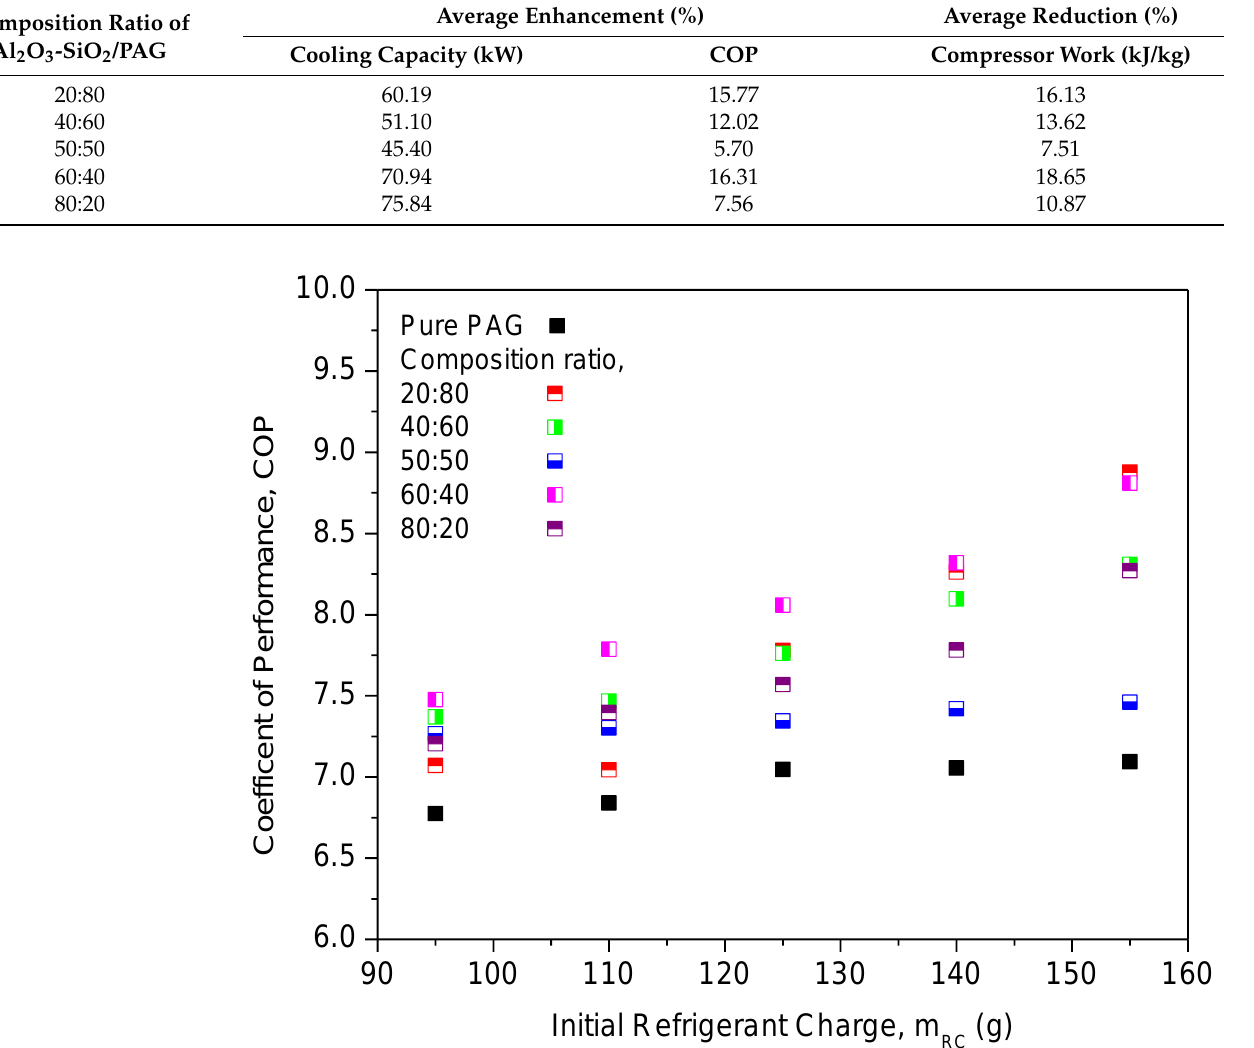
Figure 11. Coefficient of performance of hybrid nanolubricants at various composition ratios.